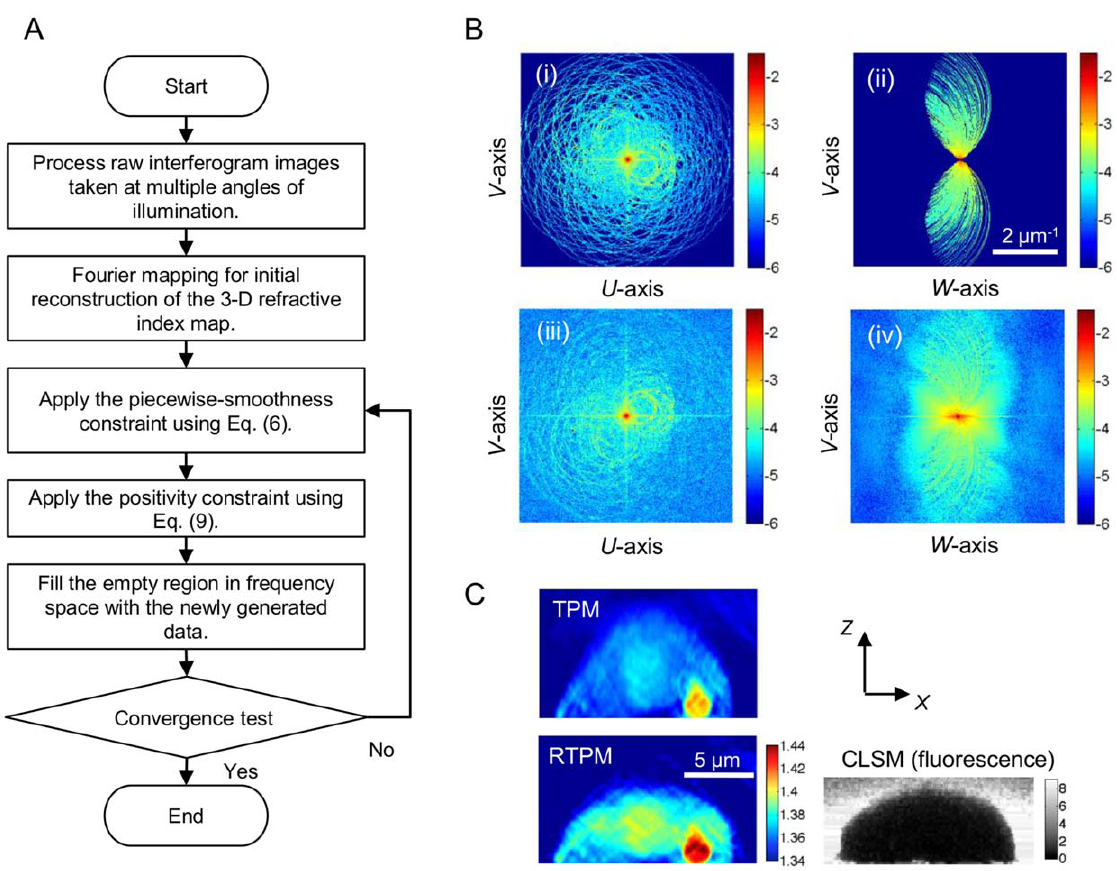
Figure 2. Data processing and validation. A: Flow chart of the iterative algorithm to retrieve the 3-D refractive index map in RTPM. B: Horizontal (i, iii) and vertical cross-sections (ii, iv) of the frequency spectrum of the 3-D refractive index maps before (i, ii) and after 50 iterations (iii, iv). The colorbars for images (i-iv) represent the amplitude of the frequency spectrum shown in logarithmic scale, base 10. C: Vertical cross-sections of the refractive index map for a HeLa cell obtained with TPM, RTPM, and CLSM. The value in the CLSM image is the amplitude of signal recorded using photomultiplier tubes, which represents the fluorescence intensity of fluorescein molecules added to the medium.